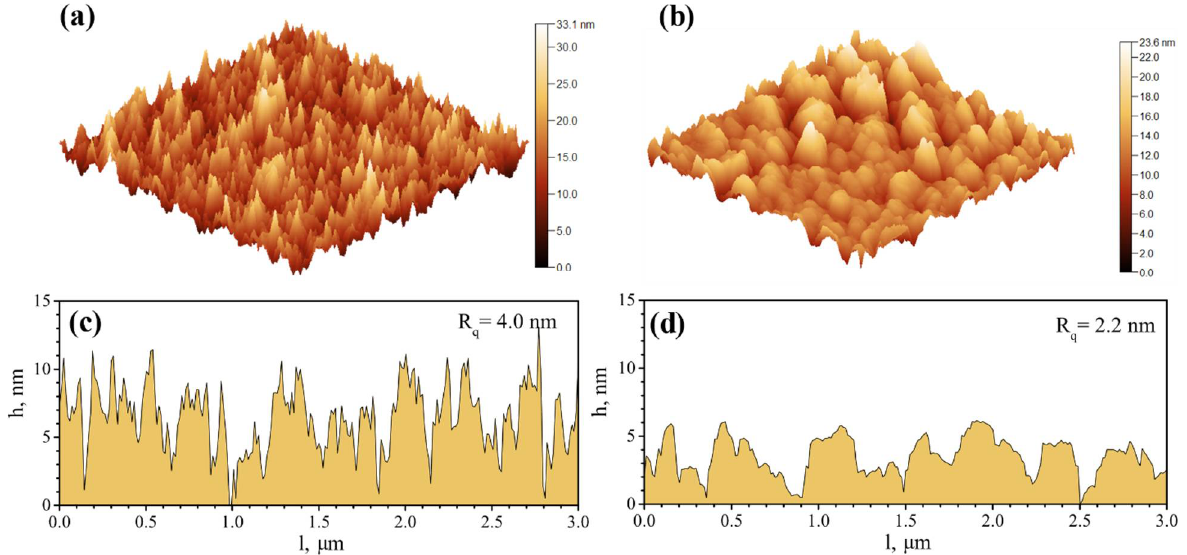
Figure 2. AFM images of ScAlSZ thin films: ( a , c ) c Al = 1.6 at.% and ( b , c ) c Al = 15.9 at.%. XRD identified that ScAlSZ thin films were amorphous when Al concentration in thin films was 22.2 at.% and crystalline when Al concentration was lower (Figure 3a). However, the crystalline phases were different depending on the concentration of aluminum. The XRD pattern of ScAlSZ thin films containing 15.9 at.% of Al consisted of peaks belonging to the tetragonal phase of zirconia (JCPSD No. 01-084-9828). The XRD patterns of ScAlSZ thin films with low (1.6 and 3.8 at.%) Al concentration had peaks belonging to the cubic phase of scandia stabilized zirconia (JCPSD No. 01-089-5485) and the tetragonal phase of zirconia (JCPSD No. 01-084-9828).